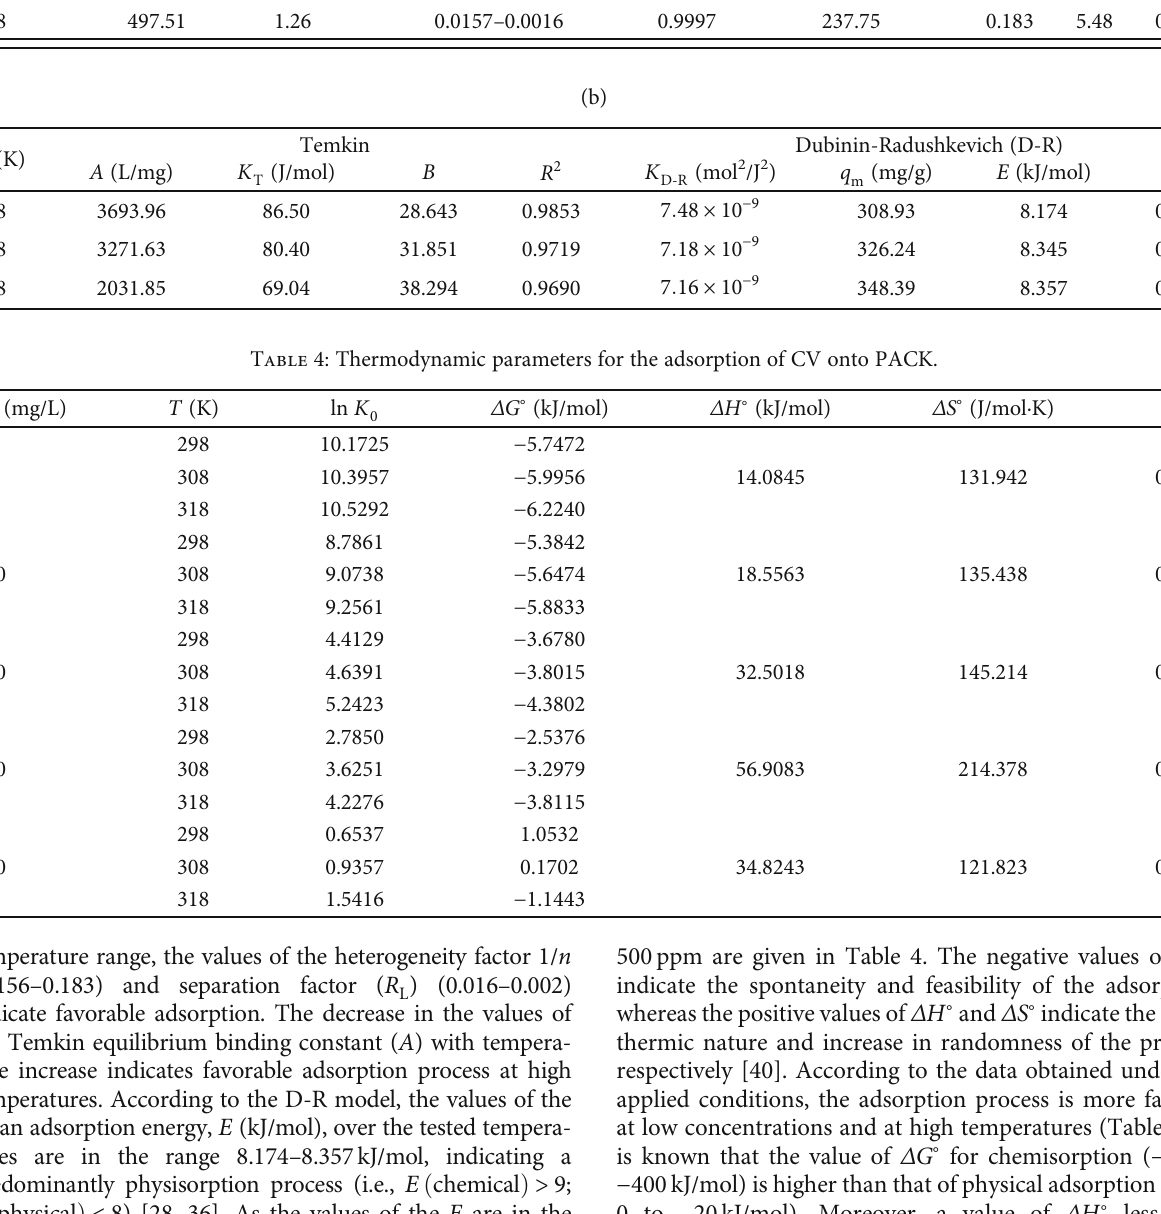
Table 3: Langmuir, Freundlich, Temkin, and D-R isotherm parameters for CV adsorption onto PACK. Temp. (K)